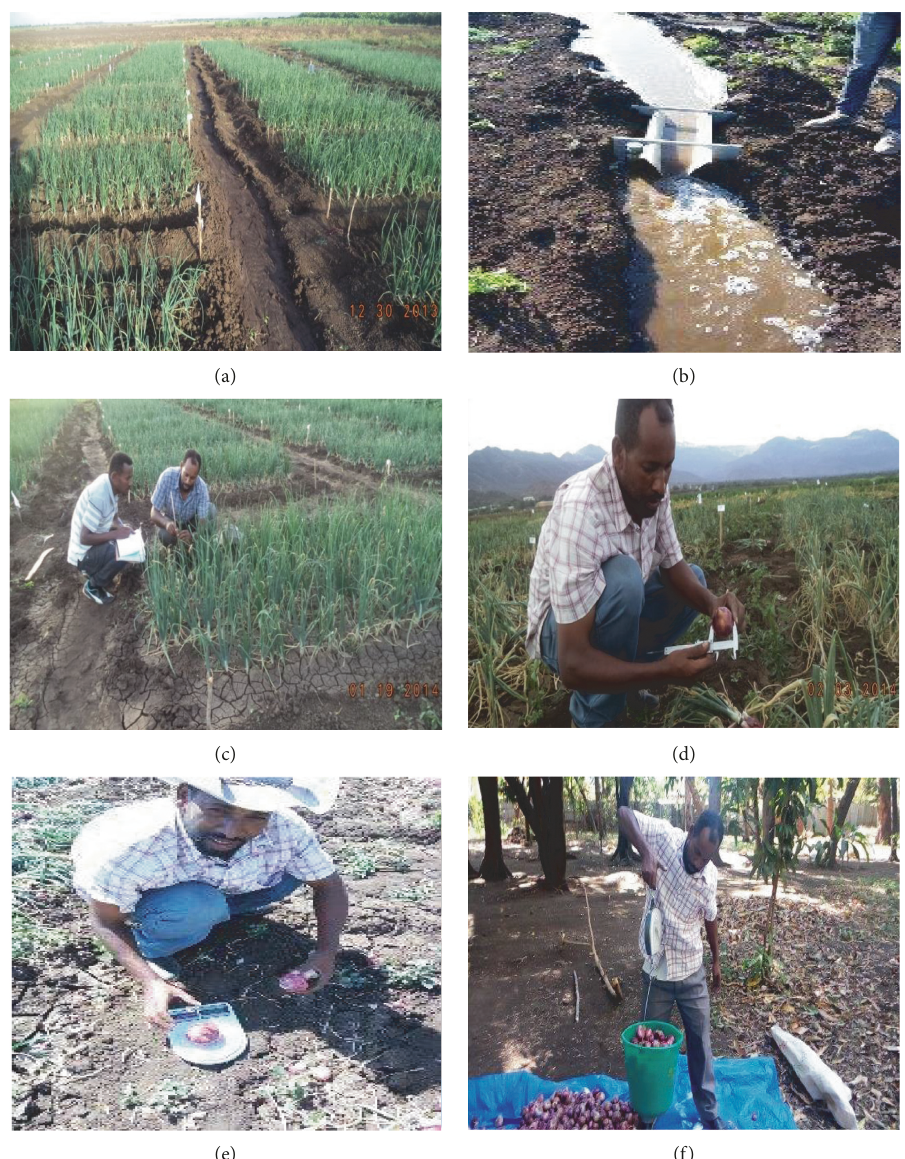
Figure 4: View of experimental plots, irrigation water measurement and recording of growth and yield of onion. (a) Experimental plots. (b) Irrigation water measurement by a parshall flume. (c) Measurement of plant height. (d) Measurement of bulb diameter. (e) Recording bulb weight. (f) Recording bulb yield in the